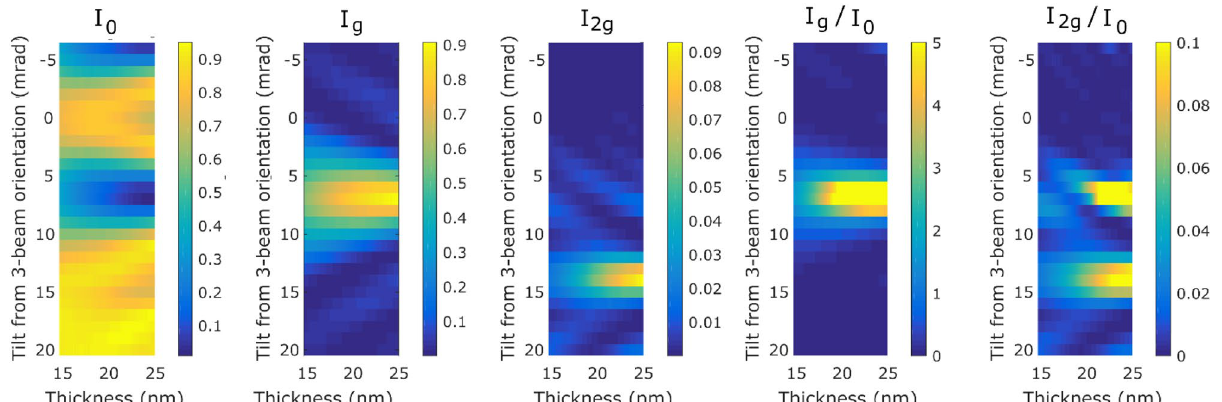
Figure 1. Results from elastic scattering calculations of the intensities of the transmitted beam and the Bragg scattered beams g = (200) and 2 g as a function of tilt from three-beam orientation and sample thickness for bcc iron crystal at 300 kV acceleration